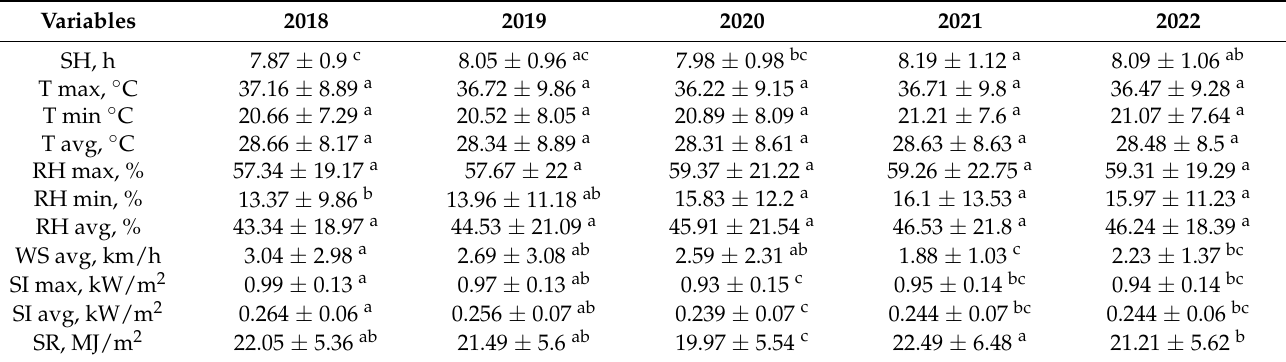
Table 1. A comparison among the average yearly values ( ± standard deviation) of the meteorological variables of the experimental area for the five